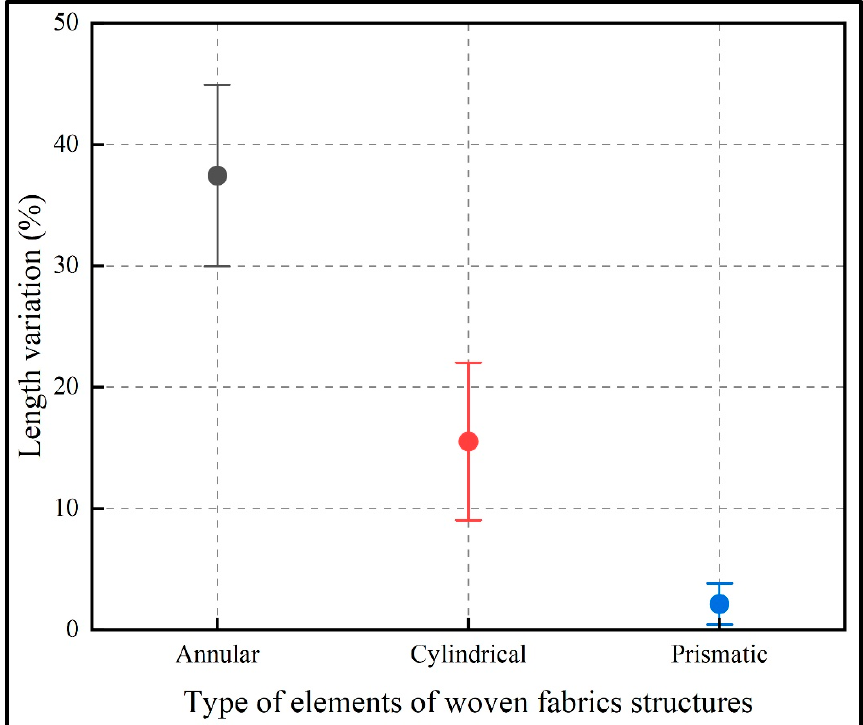
Figure 12. Average variation of 3D printed structured fabrics length. Table 4. Fineness and fabric areal densities of 3D printed fabric